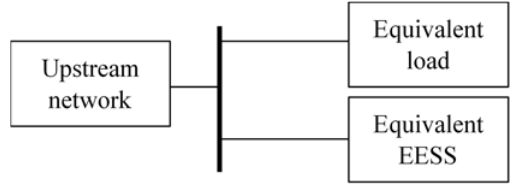
Figure 2. Busbar system considered in the inner routine.